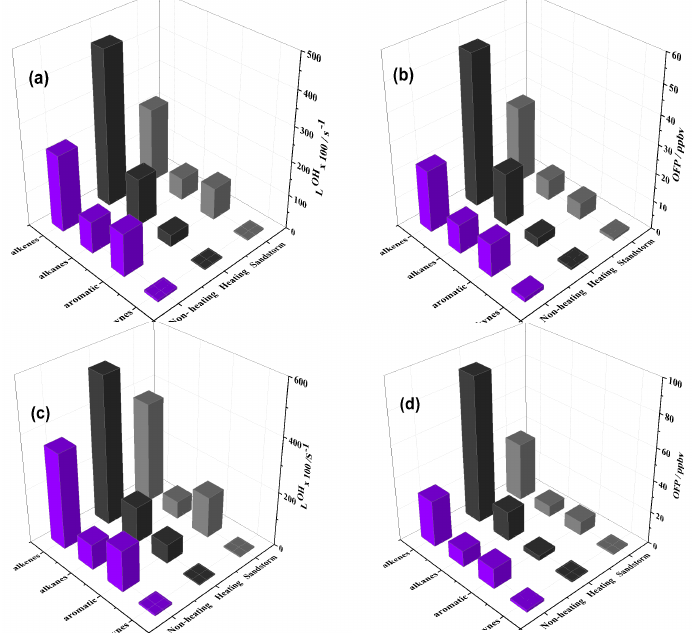
Figure 3. The observed and ( a , b ) initial ( c , d ) average OH · loss rate (L OH ) and ozone formation potential (OFP) of each group of VOCs of for the non-heating, heating, and sandstorm periods. Table 2. Top ten species with the highest L OH and OFP values in the atmosphere of the Dushanzi district.